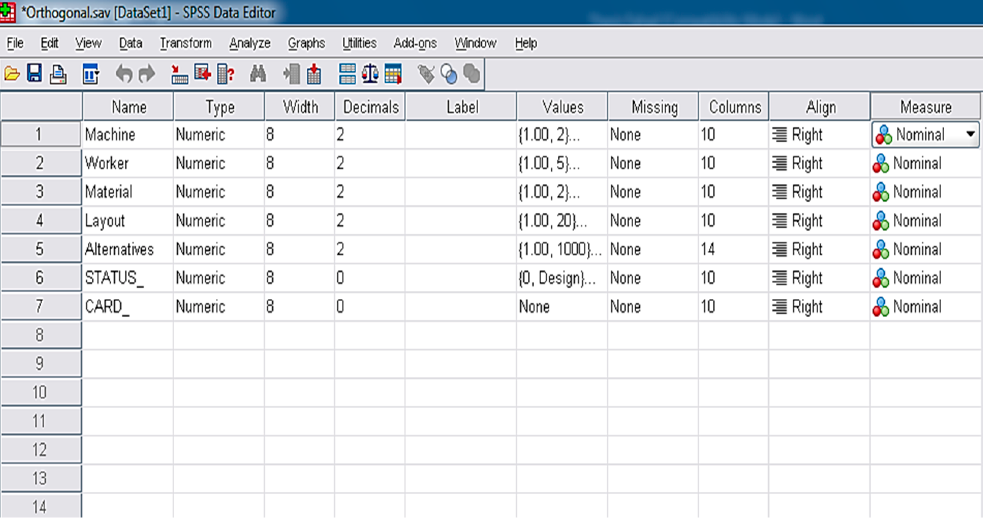
Figure 21. Summary of the designed orthogonal method by SPSS.